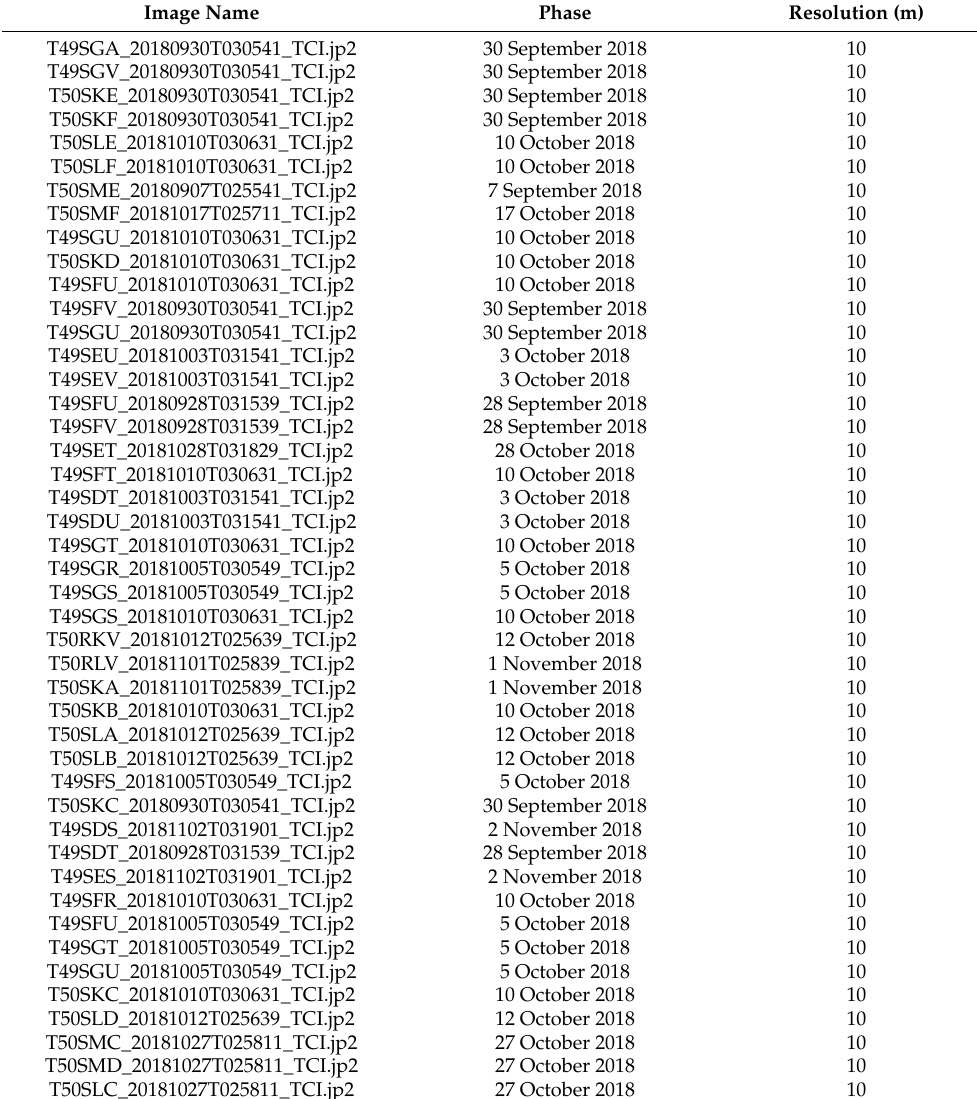
Table 1. Sentinel-2 remote-sensing imaging data used in this